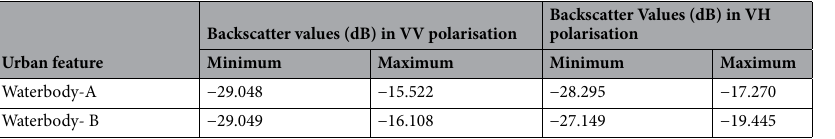
Table 12. Summary of variations in backscatter values for urban water features. Selected Urban Water body feature-A and feature B (Location 1 & 2).